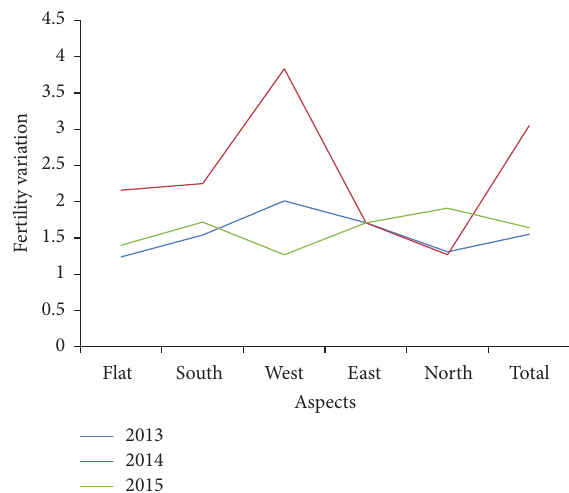
Figure 2: Fertility variations for aspectual populations and